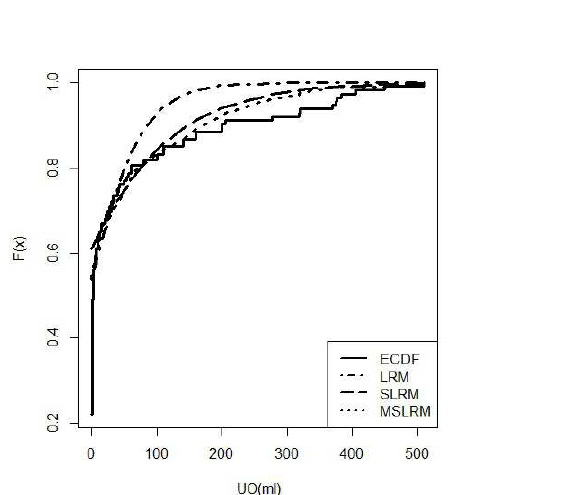
Figure 3 – ECDF of the data set2 and fitted regression models - LRM, SLRM and